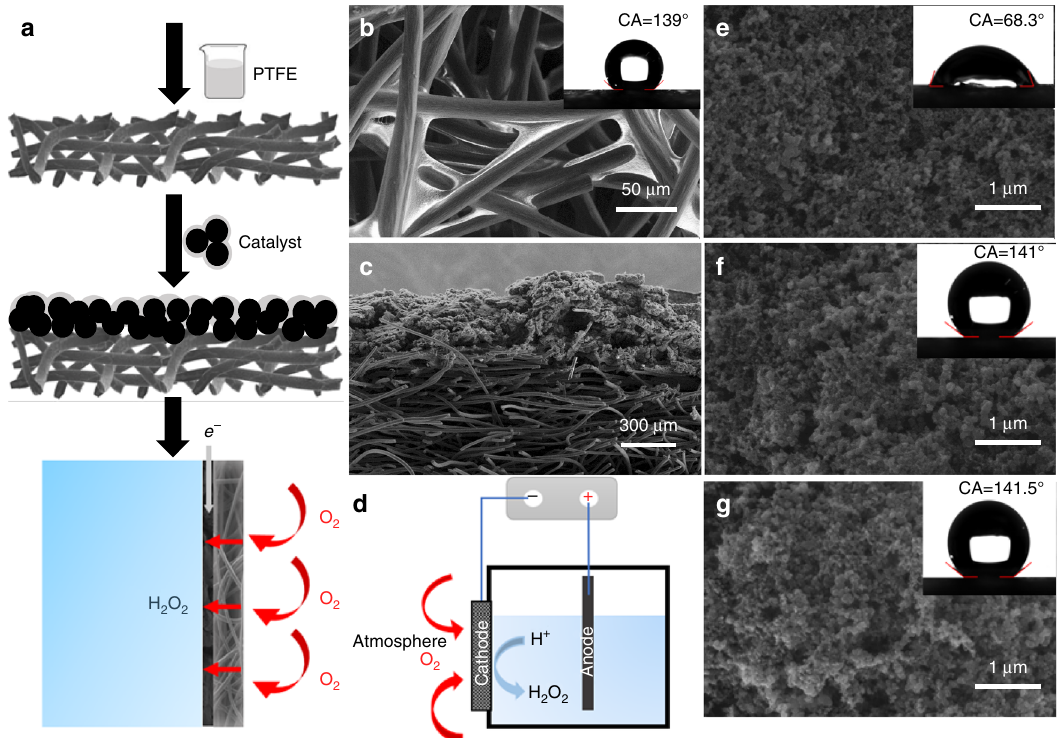
Fig. 1 Schematic illustrations and SEM images of NADE. a NADE fabrication process and schematic illustration of the three-phase electrocatalytic system. b SEM images and contact angle of modi fi ed carbon felt (inset). c SEM images of the modi fi ed carbon felt substrate coated with carbon black. d Schematic diagram of NADE electrocatalytic reactor; SEM images of catalytic layers with e PTFE/CB = 0.1, f PTFE/CB = 0.6, and g PTFE/CB =